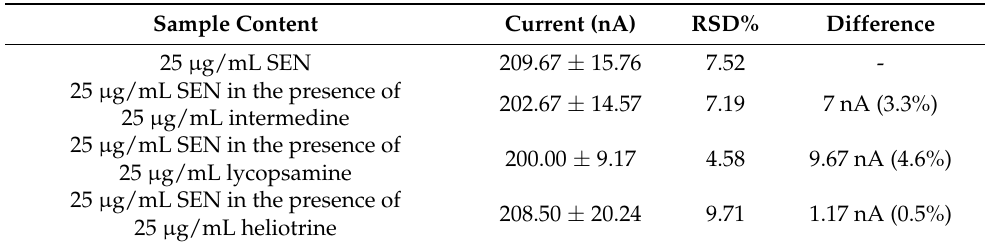
Table 1. The average oxidation signal of SEN in the absence/presence of intermedine, lycopsamine, or heliotrine with RSD% ( n = 6) and values of difference at SEN signal.